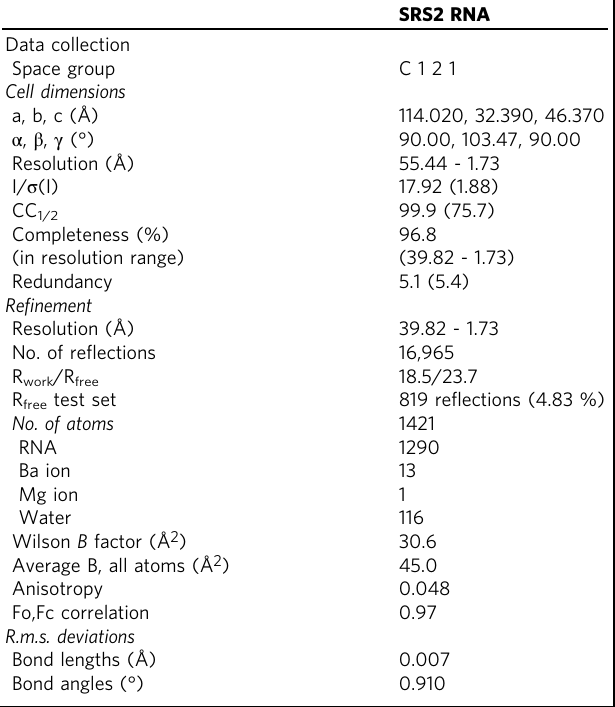
Table 1 Data collection and re fi nement statistics (molecular replacement)